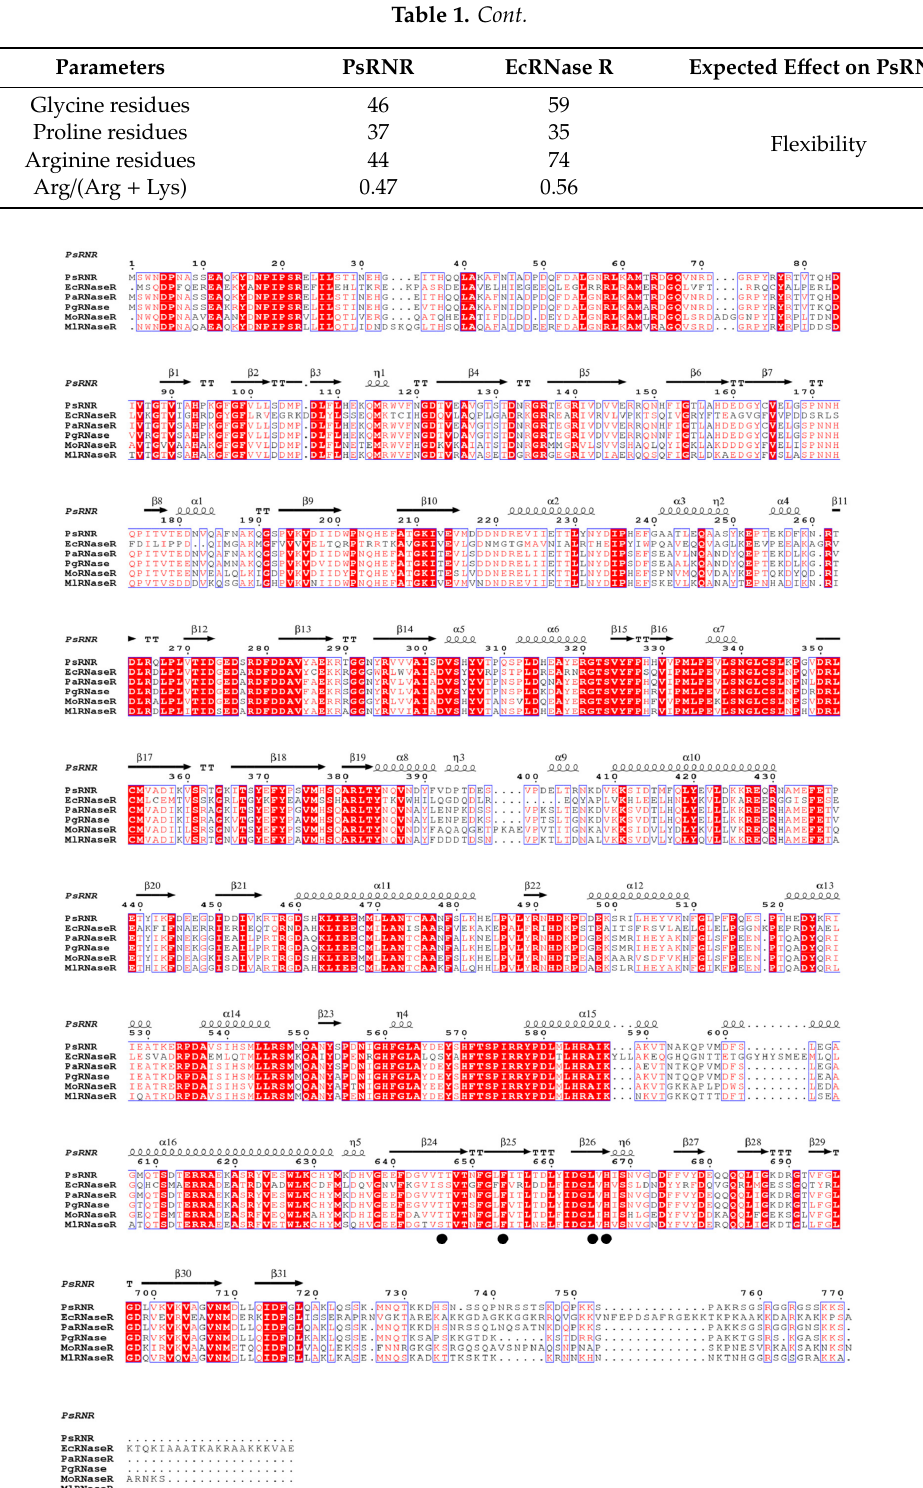
Figure 1. Alignment of the PsRNR sequence with other RNase R. The species names and